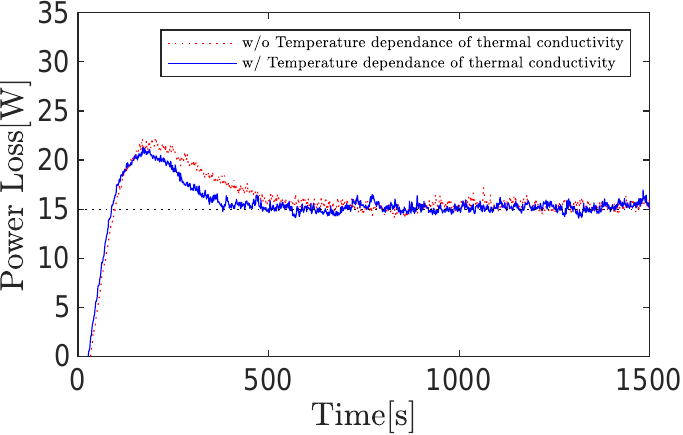
Figure 14. Endothermic quantity of Peltier device u c at 15 W (w/o operator theory).